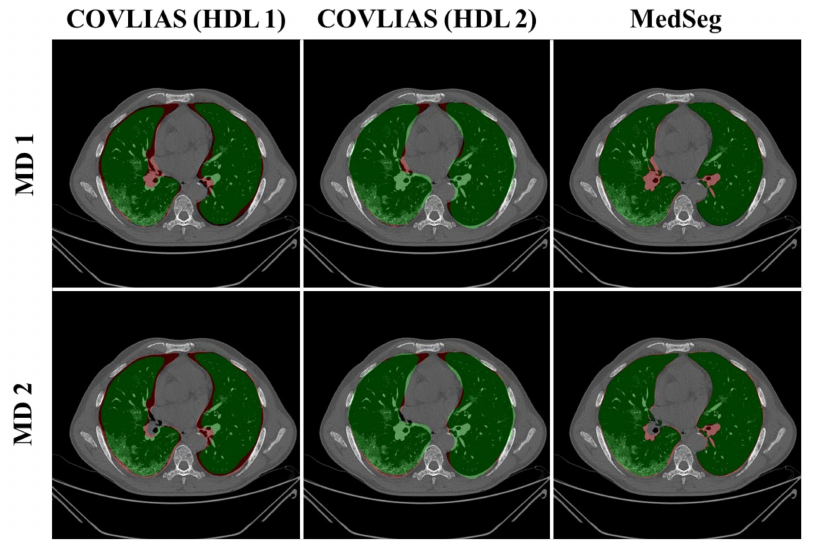
Figure 9. COVLIAS (HDL 1) (green) in column 1; COVLIAS (HDL 2) (green) in column 2; MedSeg (green) in column 3, MD 1 in row 1 (red); MD 2 in row 2